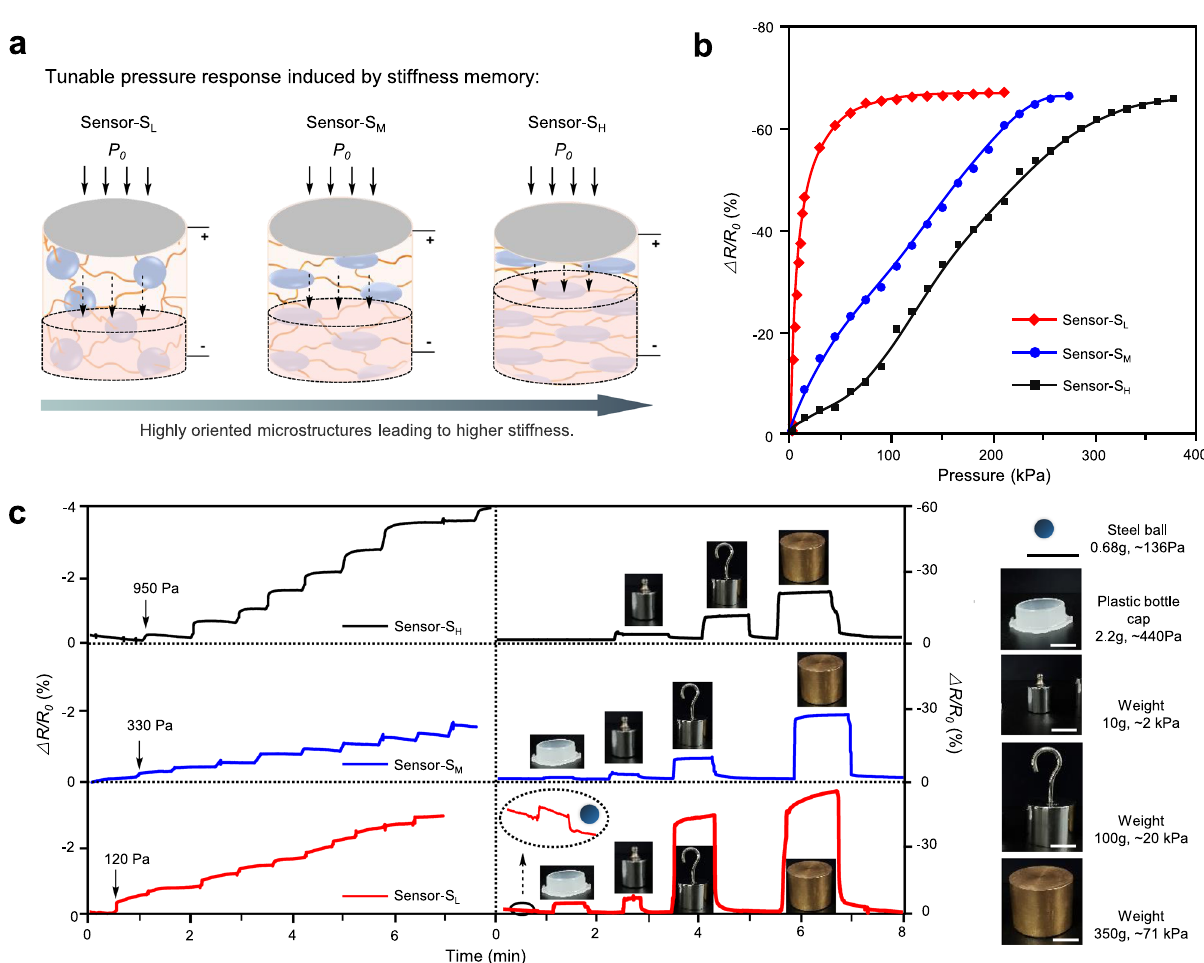
Fig. 3 Wide pressure range and tunable detection limit of the ionogel pressure sensors. a Illustration showed the pressure-response change with varied stiffness of the heterophasic ionogels. Sensors with oriented structure and higher stiffness revealed less deformation under the same pressure. b Pressure- resistance response of the sensors with low (sensor-S L ), middle (sensor-S M ), and high stiffness (sensor-S H ) in the pressure range from 0 to 400 kPa. c Detection limit of the pressure sensors with different stiffness. The three sensors responded differently to a series of pressure objects: steel ball, plastic bottle cap, and weights. Scale bar, 1